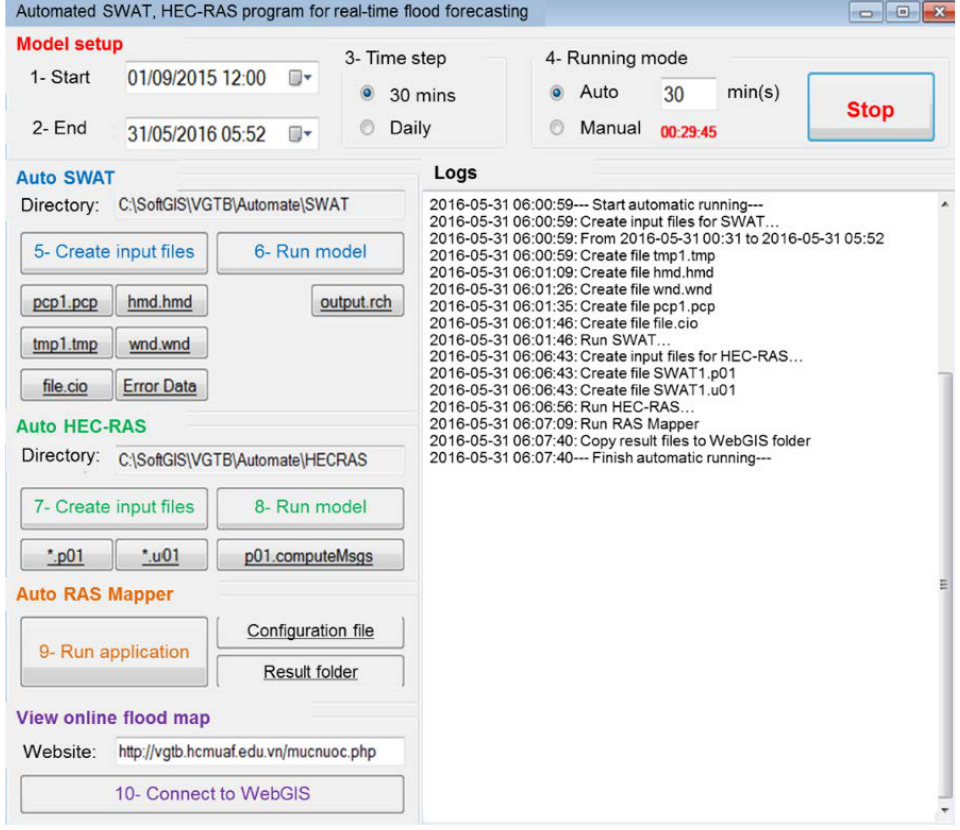
Figure 8. Automated SWAT and HEC–RAS module for real-time flood forecasting.